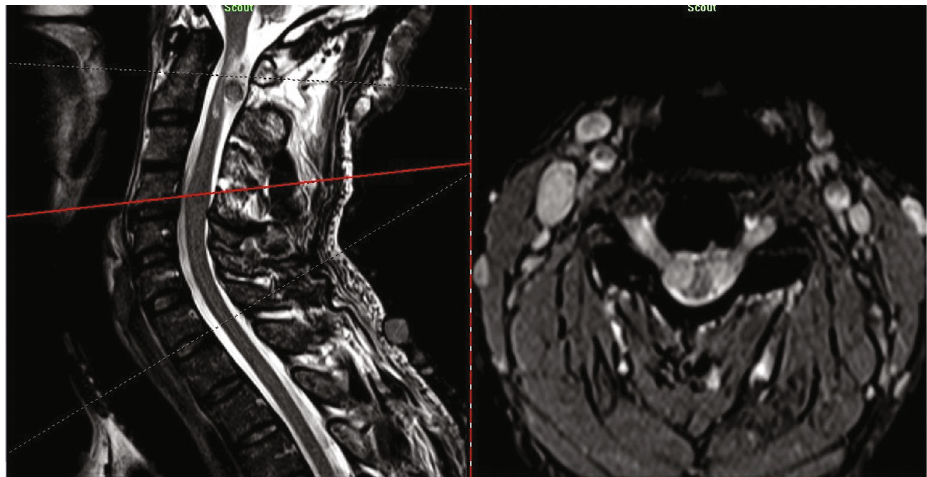
Figure 4: Sagittal-axial T2WI cross view of C4-C5 level showing bilateral symmetrical intradural ventrolateral C4 GN, compressing spinal